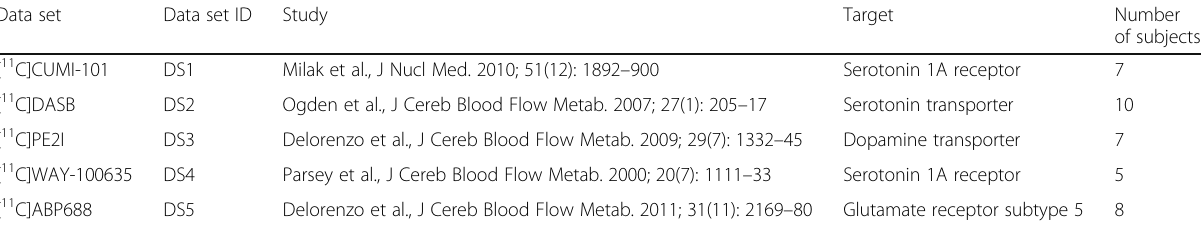
Table 1 Summary table of the considered clinical brain PET test-retest data sets Data